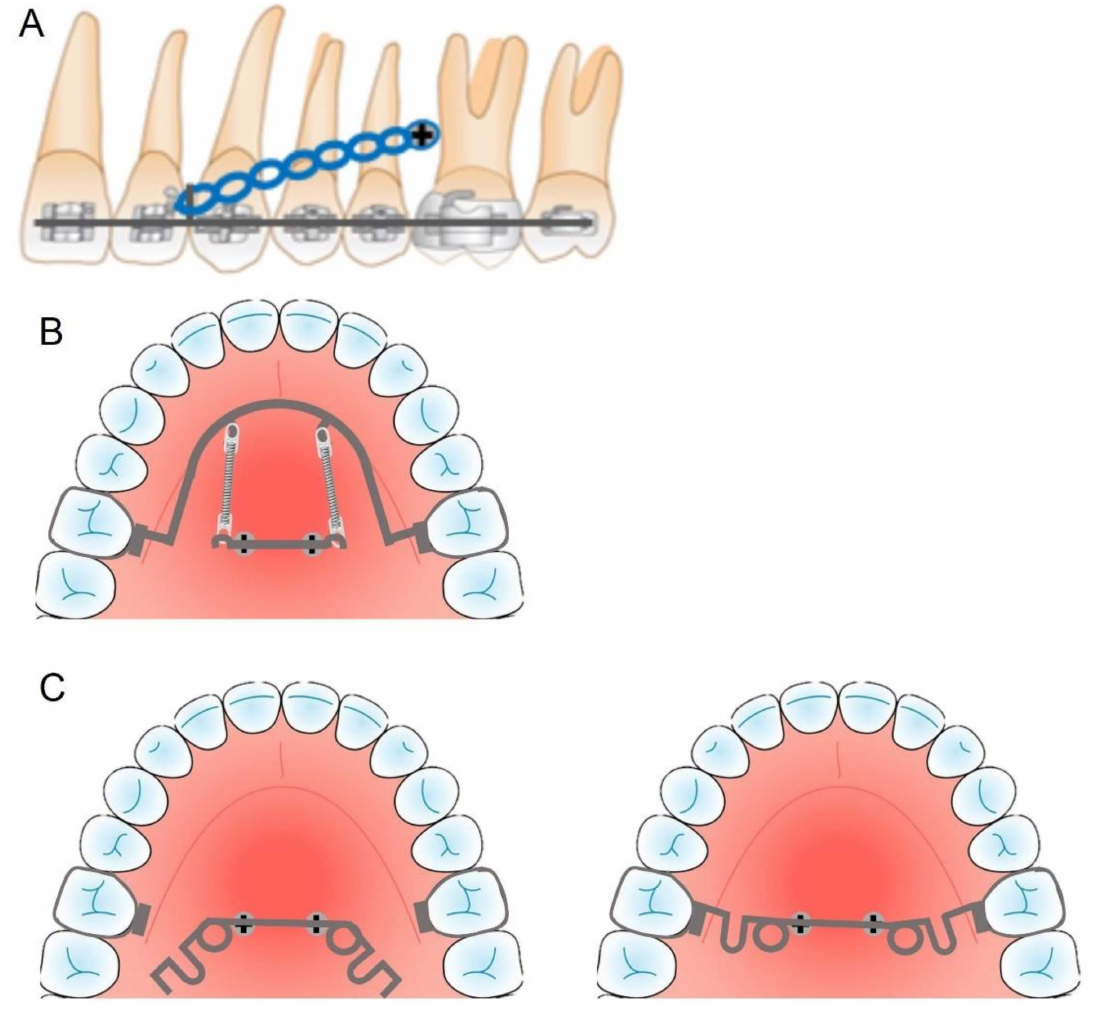
Figure 1. Schematic diagrams of maxillary molar distalization TAD appliances ( A ), group 1; ( B ) group 2; ( C ) group 3; From the left: before activation and after